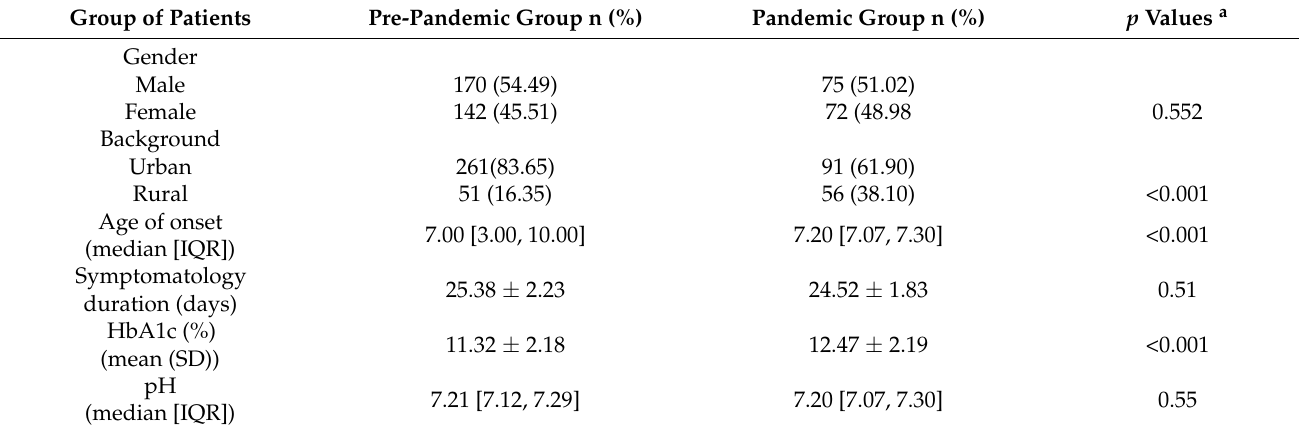
Table 1. Characteristics of the study sample according to the time of diagnosis.